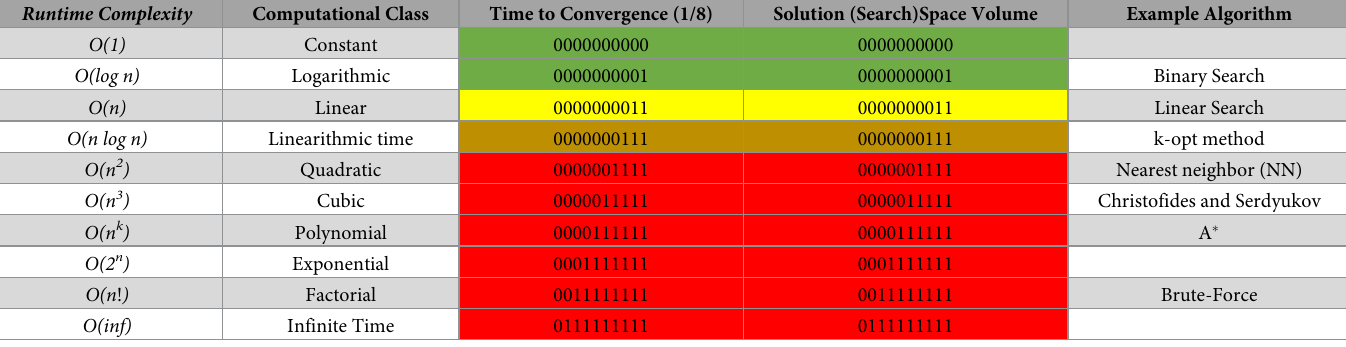
Table 11. Classes of computational